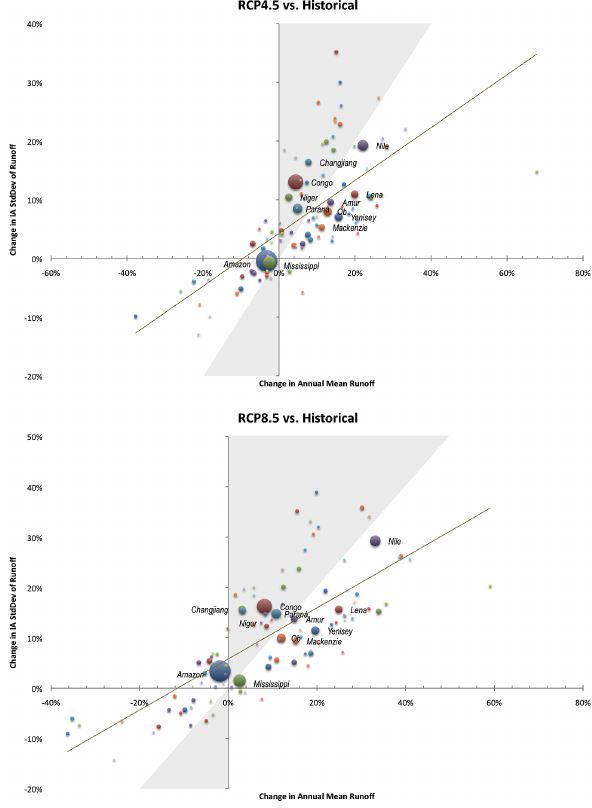
Figure 11. Percentage change in IASD of monthly mean runoff averaged for all months versus percentage change in annual mean runoff for the cases shown. The 12 largest river basins are labeled, and the sizes of the dots are proportional to the rank of the size of the basin. The least-squares best-fit line through the points is shown. Shading indicates the region where there is a greater percentage in- crease in standard deviation than percentage increase in